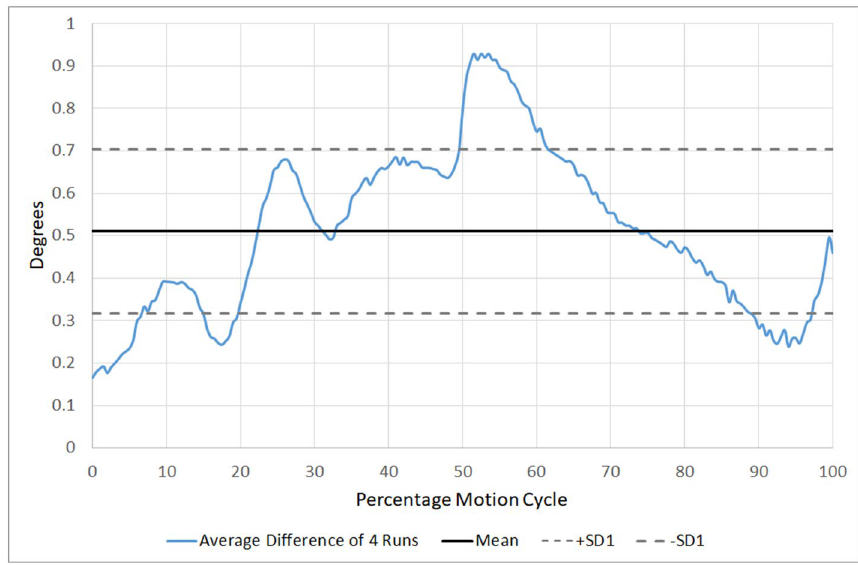
Figure 3. Example of the mean Motor Control and its standard deviation at C3–4 for one participant.